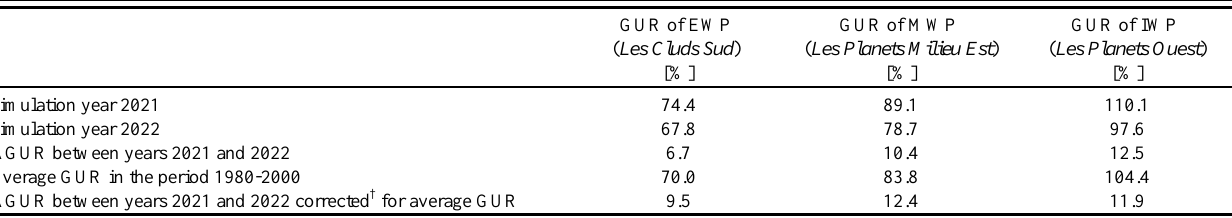
Table 3 . Simulated impact of drought on global utilization rates (GUR) in the three studied wood-pastures. An arbitrarily comparison of a hot year (2021, growing season mean air temperature 11.3 °C) to a normal year (2022, growing season mean air temperature 9.6 °C) under the B2 IPCC-SRES scenario. Long-term (1961-2010) average of the growing season temperature is 9.0°C.